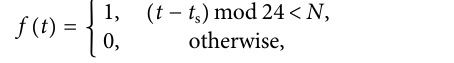
Frontiers in Applied Mathematics and Statistics |